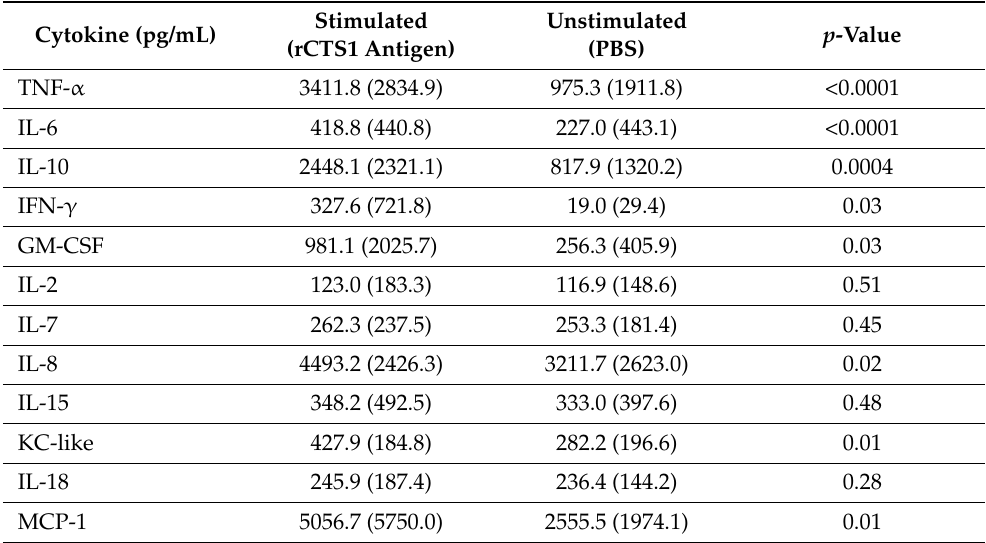
Table 3. Comparison of supernatant cytokine concentrations in 28 dogs with coccidioidomycosis after stimulation of peripheral blood cells with rCTS1 antigen or unstimulated in phosphate-buffered solution (negative control). Data presented as mean and standard deviation.